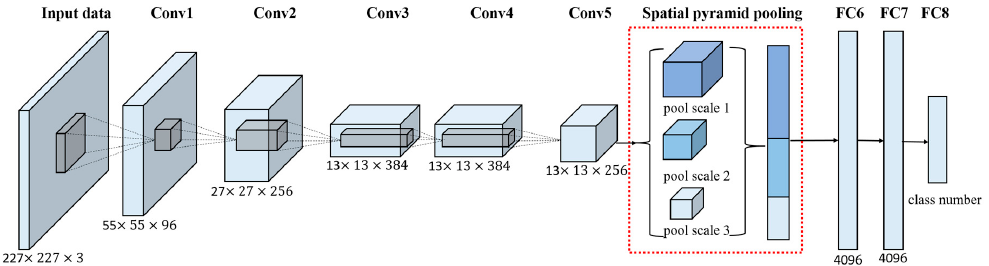
Figure 2. The AlexNet architecture with spatial pyramid pooling.